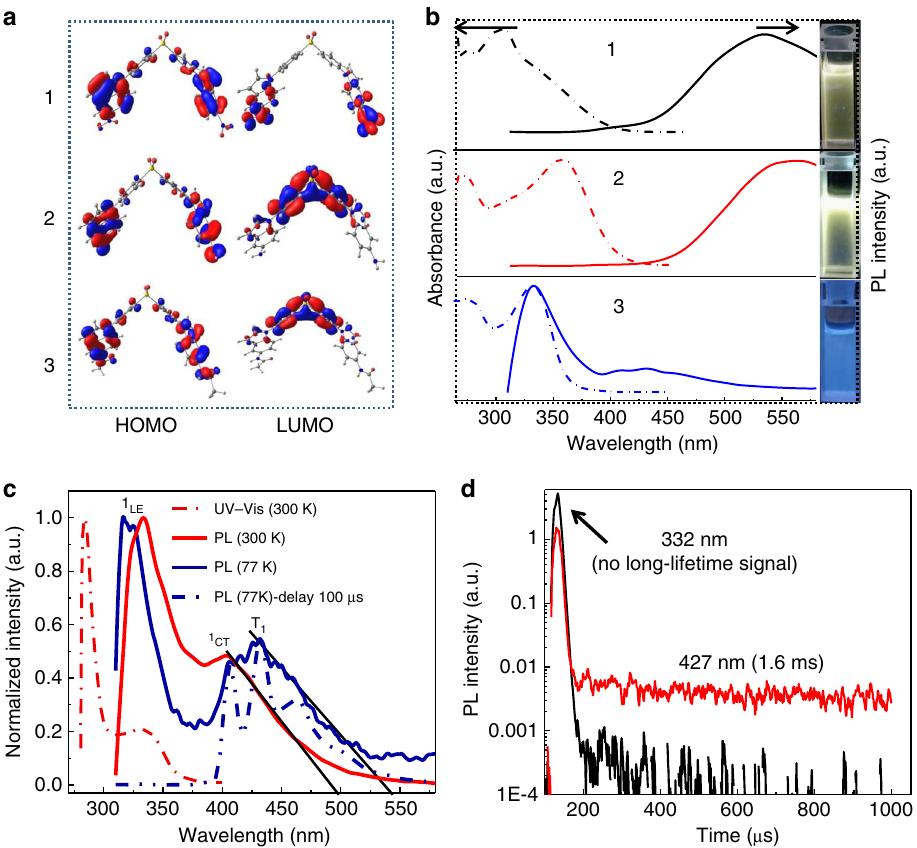
Fig. 2 Photophysical study. a HOMO and LUMO of compounds 1, 2, and 3 calculated at the B3LYP/6-31G(d) level. b Absorption and emission spectra of the three compounds in DCM (2 μ M) at room temperature. Inset: photographs under a UV light (365 nm). c UV/Vis absorption spectra at 300 K (red dash-dot curve), photoluminescence spectra at 300 K (red curve), at 77 K (blue curve), and photoluminescence spectra at 77 K with delay (blue dash-dot dot) of 3 in toluene (2 μ M). d PL lifetime at 77 K. DCM, dichloromethane; HOMO, highest occupied molecular orbitals; LUMO, lowest